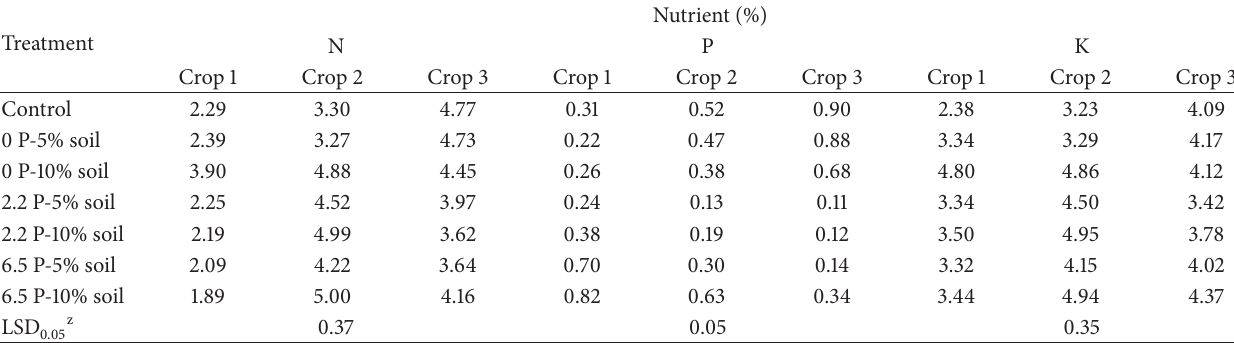
Table 3: Nutrient concentrations in tomato shoots at the end of three successive seedling crops grown in root media amended with no soil material (control) and six soil material treatments combinations containing 5 or 10% soil material (v/v) charged with 0, 2.2, or 6.5 mg ⋅ g −1 phosphate-P y